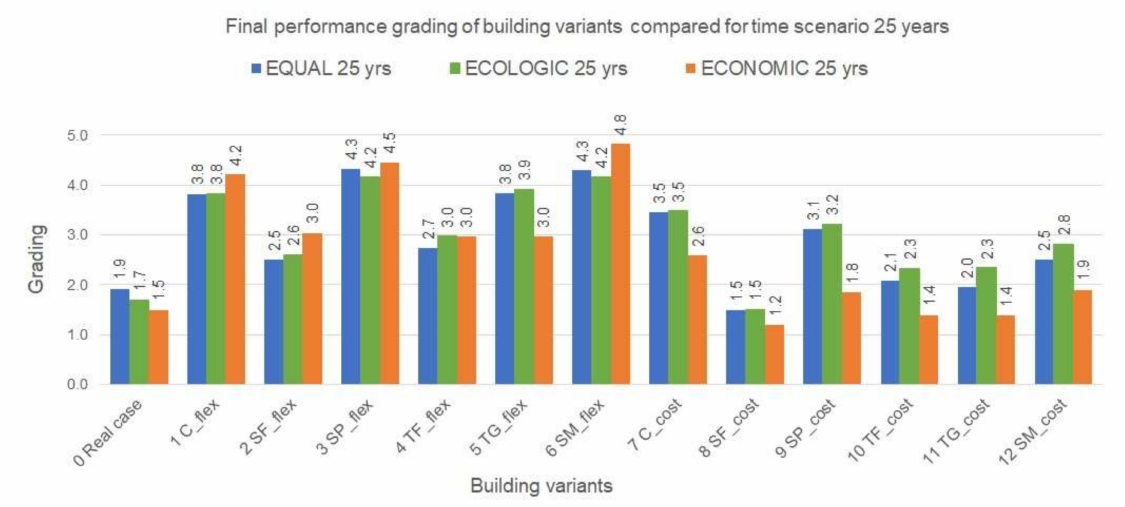
Figure 6. Final performance grading and comparison of the examined building variants for the time scenario 25 years and the weighting scenarios (equal, ecologic and